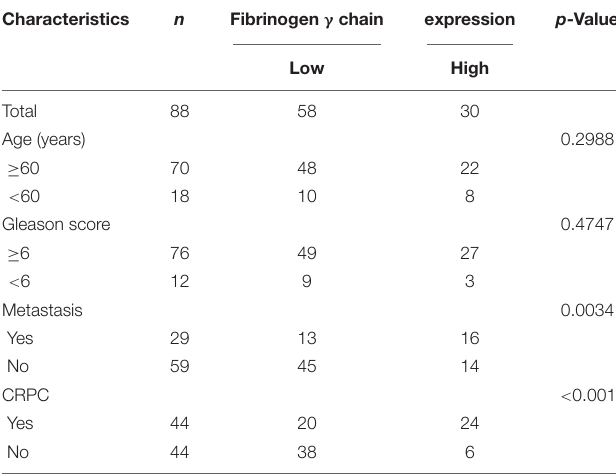
TABLE 1 | Relationship between fibrinogen γ chain expression and patient clinical